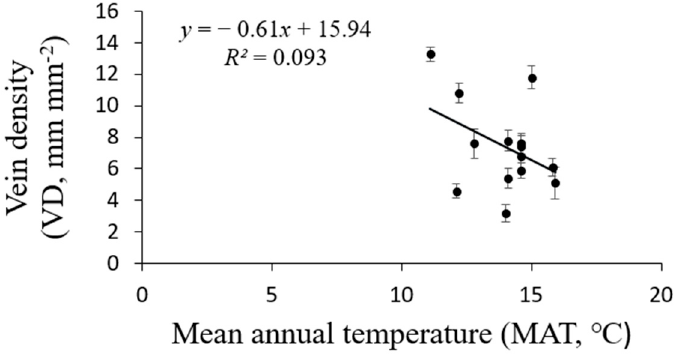
Figure 8. Regression analysis between P. subaequalis of vein density (VD) and the climatic factors of mean annual temperature (MAT) in 14 sampling sites across eastern China. Each dot represents a sampling site in China. ( p = 0.145).